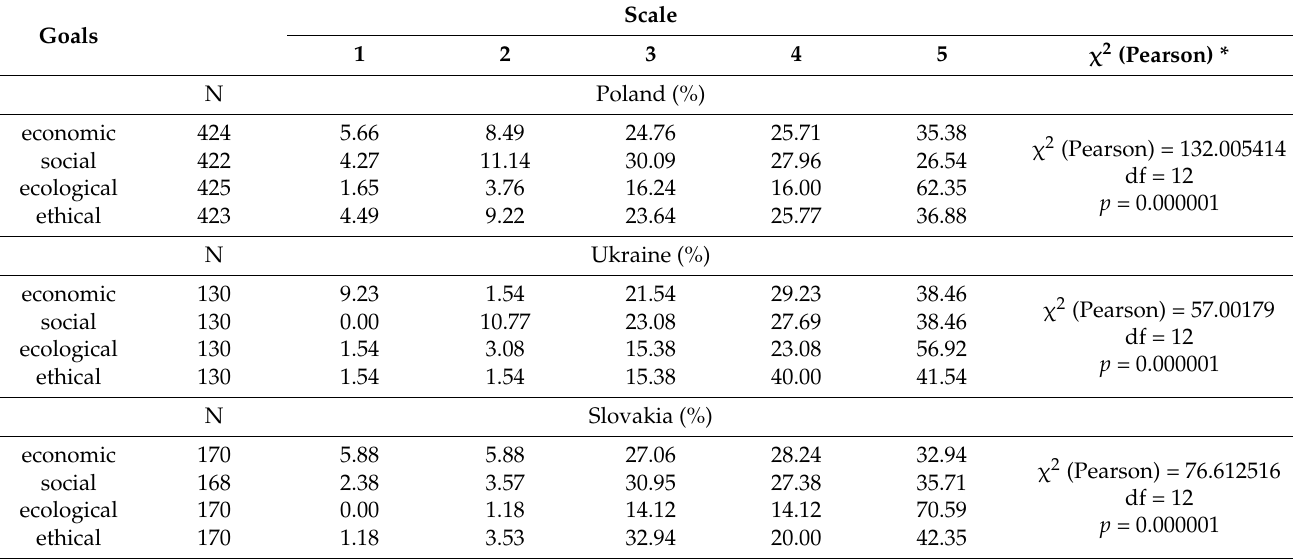
Table 13. ZW activities and its benefits for society according to respondents from Poland, Ukraine and Slovakia (scale of 1–5, where 1—does not meet this goal in general and 5—meets this goal very well). Goals